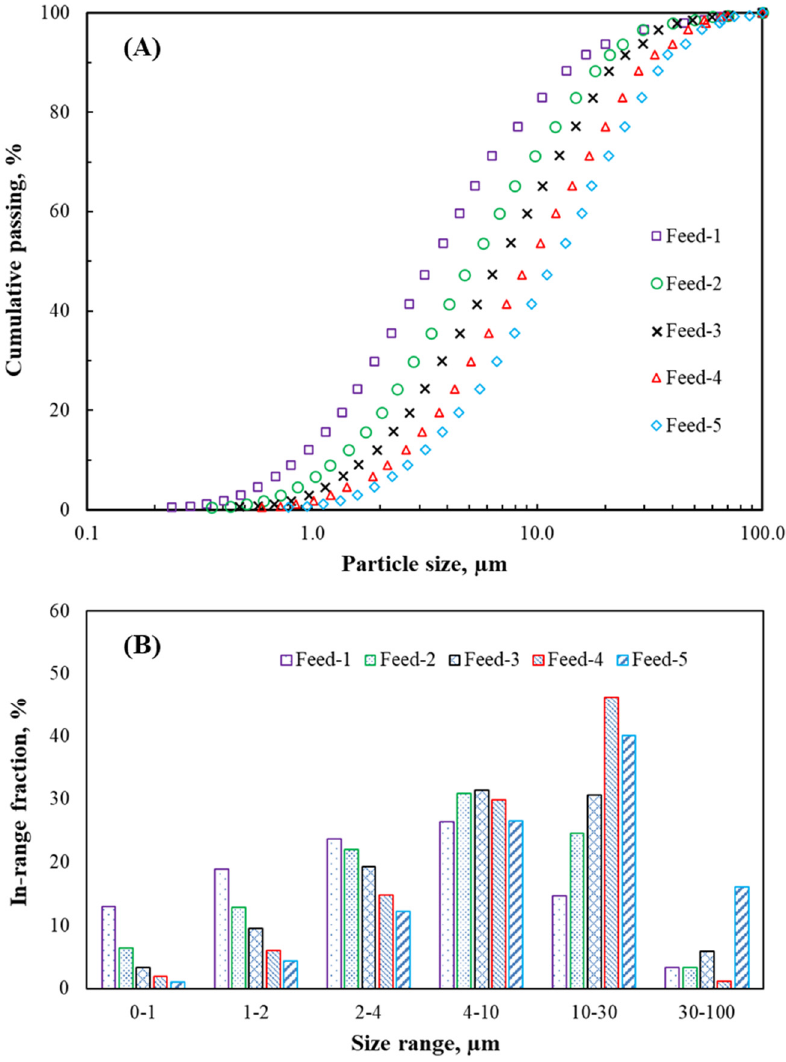
Figure 2. The particle size distributions of five feeds used for simulations (volume based): ( A ) cumulative curves, ( B ) in–range fraction histogram of the feed size.